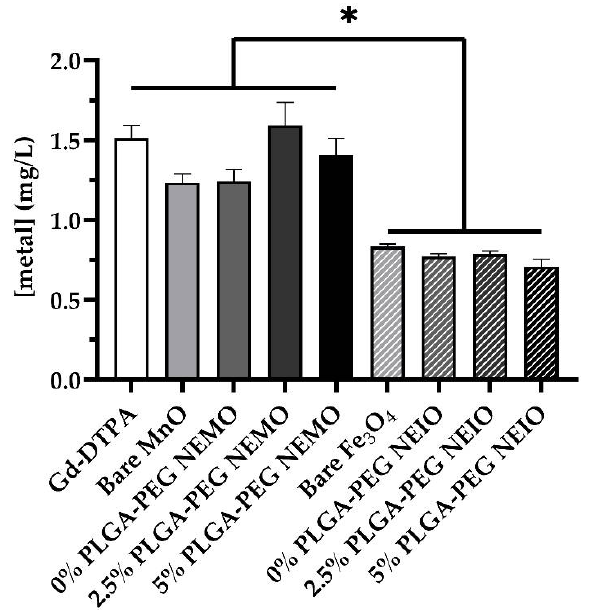
Figure 7. NEMO particles and Gd-DTPA are more readily internalized by neutrophils than NEIO particles. ICP-mass spectrometry was utilized to quantify the level of NP uptake by neutrophils for each stimulation group. The concentration of Gd, Mn, and Fe was measured in neutrophils treated with Gd-DTPA, bare MnO, the NEMO groups, bare Fe 3 O 4 , and the NEIO groups, respectively. Fe 3 O 4 NP formulations appeared to be internalized at significantly lower rates than in the other groups. * indicates significance ( p < 0.05). The error bars represent standard error.